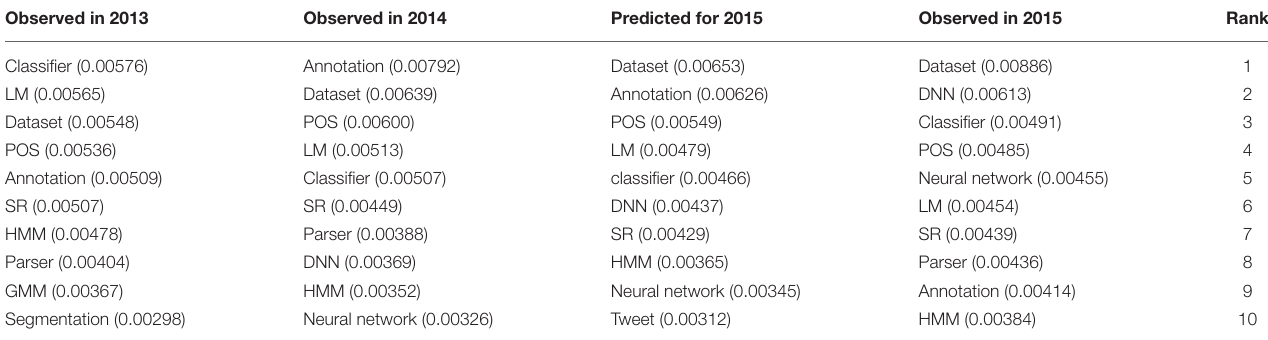
TABLE 2 | Research topics prediction using the Weka software